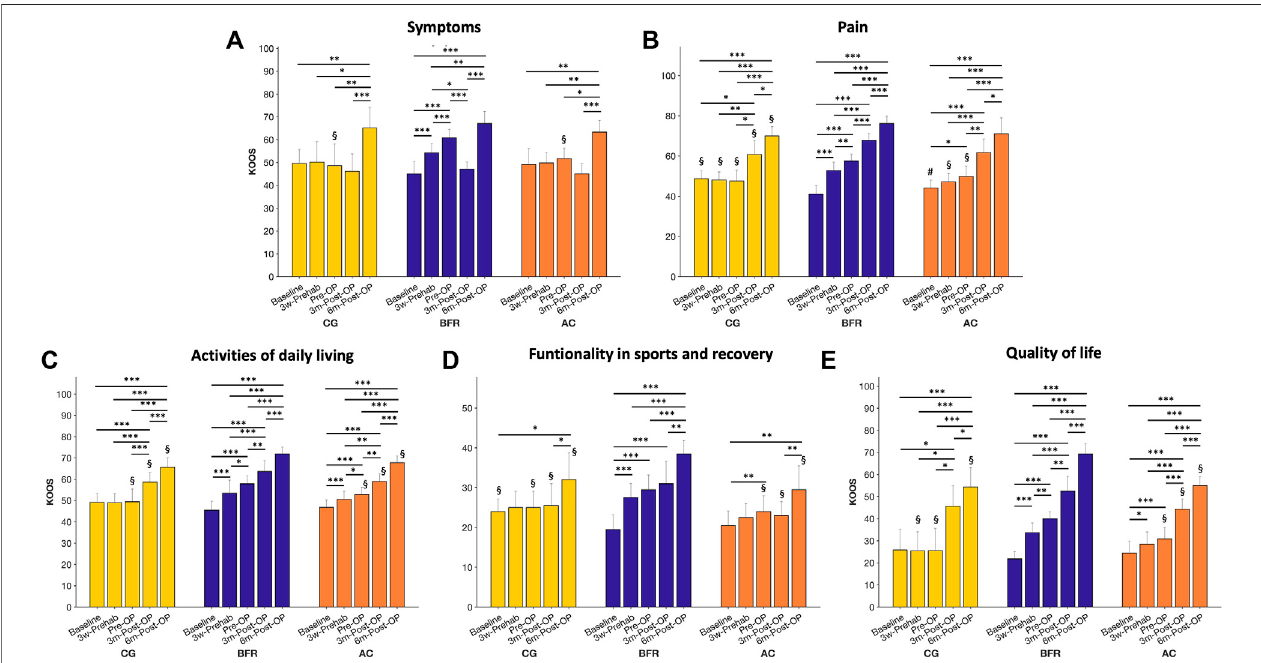
FIGURE 3 | Presentation of the fi ve subparameters (Symptoms, Pain, Activities of daily living, Functionality in sports and recovery, Quality of life) of the Knee Injury andOsteoarthritisOutcomeScore(KOOS)duringprehabilitation-andpost-operativeperiod.Dataareprovidedasmean(standarddeviation).CON,controlgroup;BFR, BFR-training group; AC, active control group. *** p < 0.001, ** p < 0.01, * p < 0.05, signi fi cant difference within the respective group. § p < 0.05, signi fi cantly different to BFR-group within the respective timepoint. # p < 0.05, signi fi cantly different to CON within the respective timepoint.